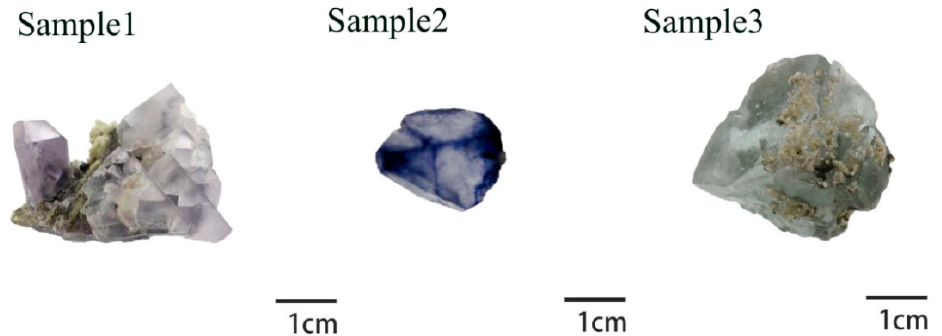
Figure 1. Photos of purple, blue, and light green fluorite samples.